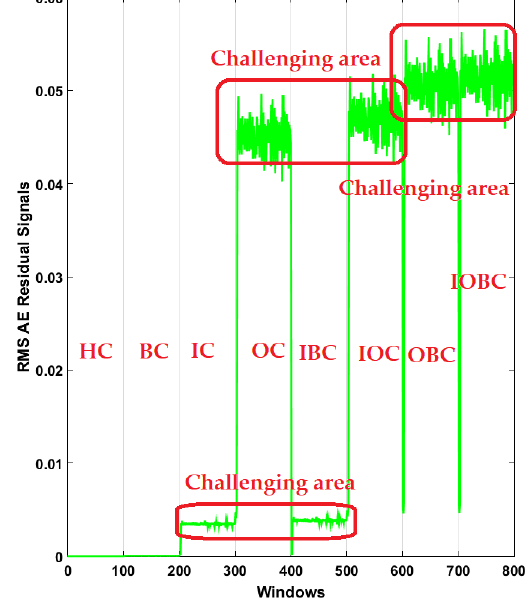
Figure 10. RMS of the resampled AE residual signals for crack type diagnosis in normal and abnormal conditions using ALSGL-SB method.